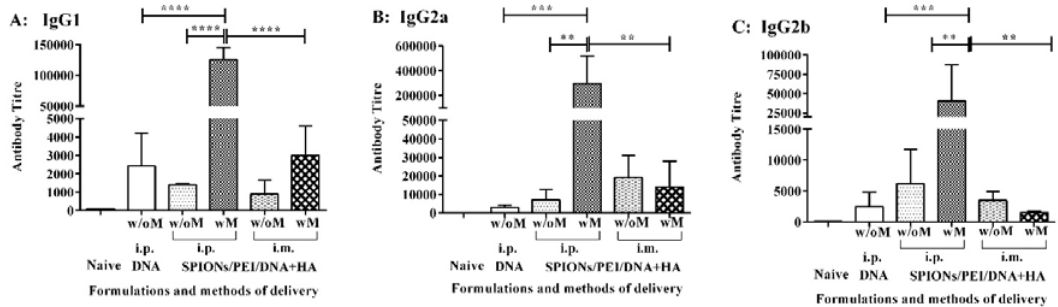
Figure 2. IgG subclasses induced by the SPIONs/PEI/DNA + HA complexes in vivo. BALB/c mice ( n = 5/group) were immunised 3 times (3 weeks apart) with either SPIONs/PEI/DNA + HA, SPIONs/PEI/DNA, or naked DNA, via i.p. and i.m. administration (naked DNA via i.p. only), with or without the application of an external magnetic field. Two weeks after the final immunisation (day 56), sera from each mouse were collected and measured for antigen ‐ specific IgG1 ( A ), IgG2a ( B ), and IgG2b ( C ) production by ELISA assay. Data represented as antibody titre mean ± SD ( n = 5 mice). Statistical analysis was performed using one ‐ way analysis of variance (ANOVA) and Tukey’s multiple comparison tests. Statistical significance was designated as ** p < 0.01, *** p < 0.001, **** p < 0.0001, ((w/M) with magnet, (w/o M) without magnet).